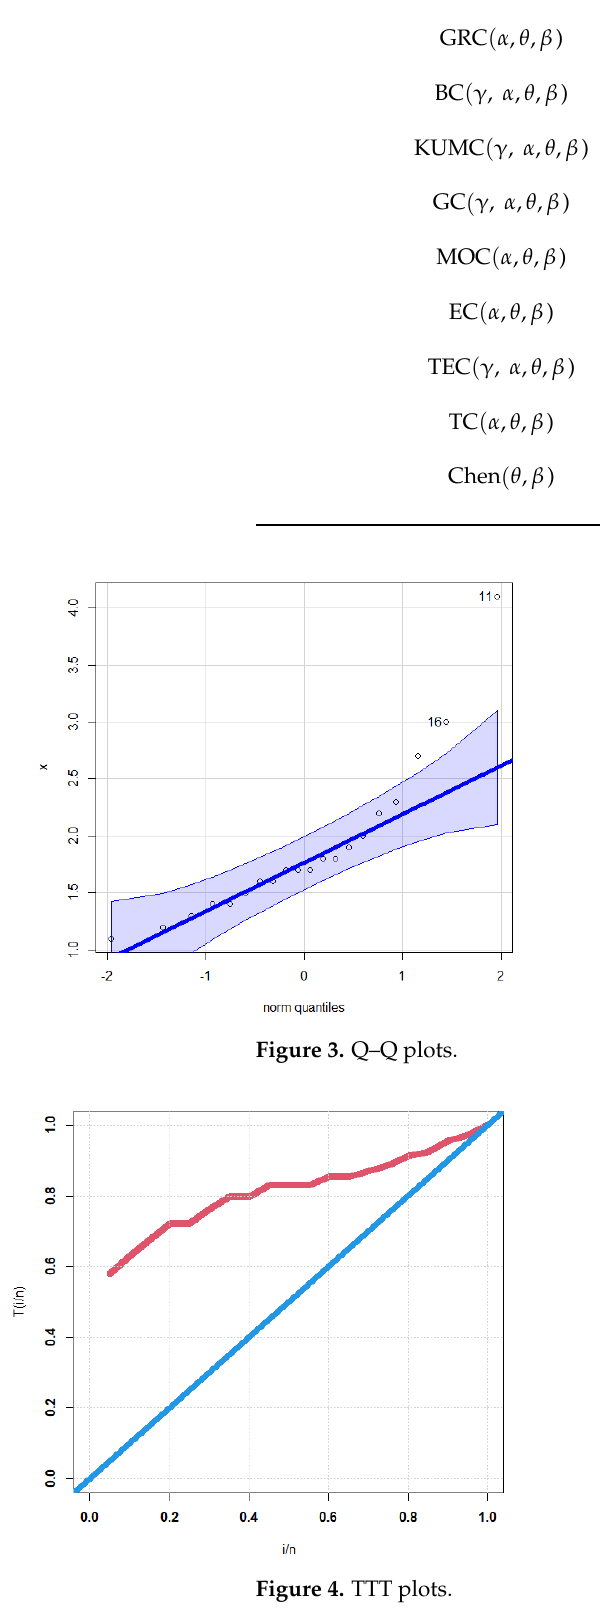
( b ) Figure 5. ( a ) The NKDE plot for the relief times data with suitable bandwidth, and ( b ) the NKDE plot for the minimum flow data with suitable bandwidth. For the relief periods and lowest flow data sets, Figures 6 and 7 show the probability – probability (P – P), estimated-PDF (E-PDF), estimated-HRF (E-HRF), and the Kaplan – Meier survival plot, respectively.